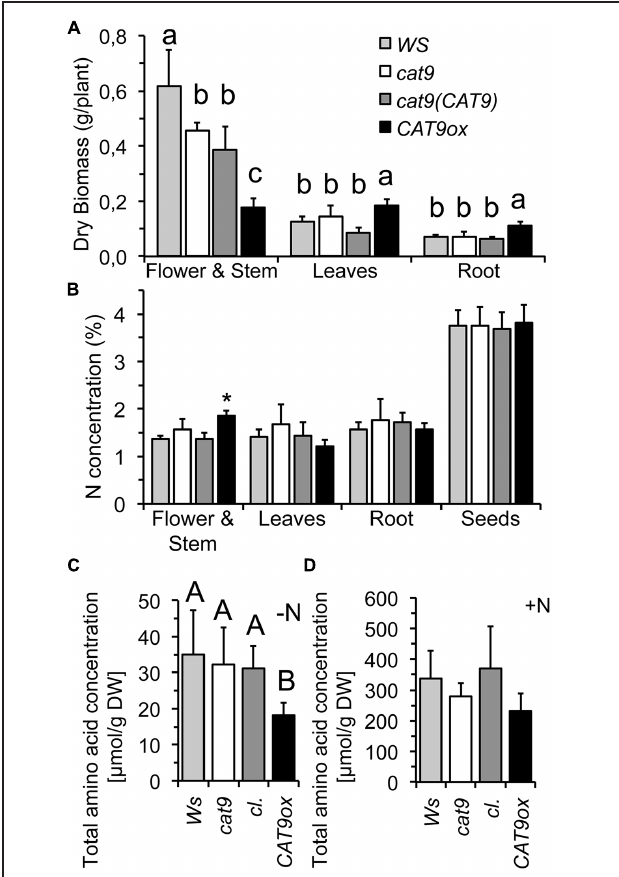
FIGURE 6 | Biomass, nitrogen, and amino acid concentrations of wild type and mutants in nutrient solution hydroponics. (A) Organ dry biomass of WS wild type (light gray bar), cat9-1 (white bar), cl (dark gray bar) and CAT9ox1 (black bar) after 5 weeks in nutrient solution. (B) Nitrogen concentration in different tissues. (C,D) Total free amino acid concentration in leaves grown only with a starting dosage of N (C) and in leaves from plants grown with 1 mM NH 4 NO 3 for 5 weeks (D) . Statistically different values (ANOVA, n = 5) are given with different capital letters or ( ∗ ) at p < 0.01 and with different lower case letters at p < 0.05.